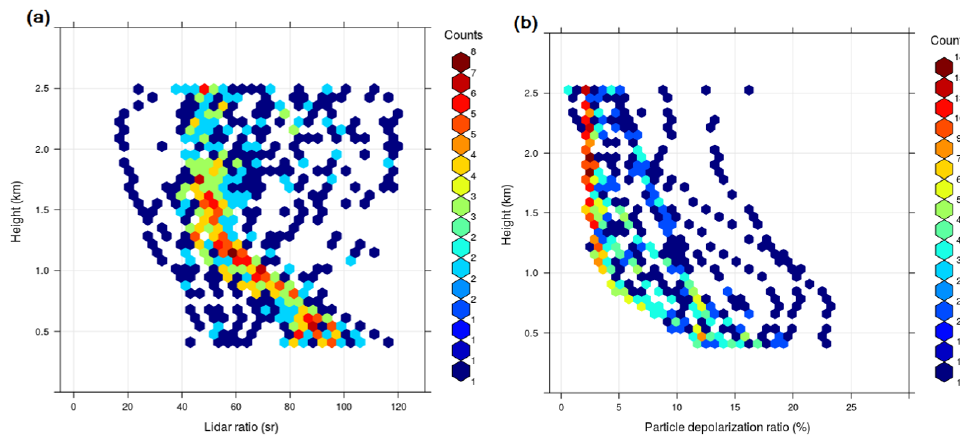
Figure 16. Occurrence distribution of vertical LR profiles ( a ) and vertical PDR profiles ( b ), both retrieved at 355nm. The number of occurrences in each bin is